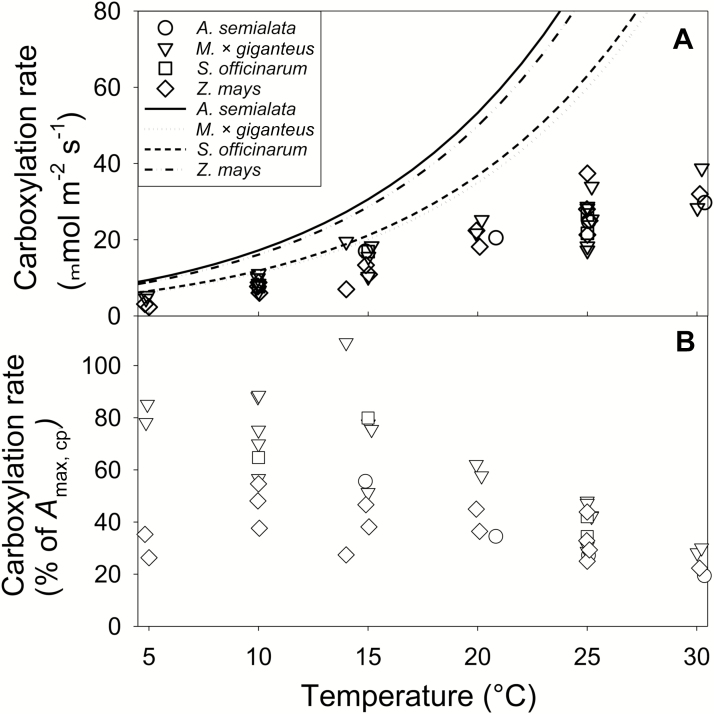
Comparison of theoretical maximum versus achieved leaf photosynthetic carboxylation rates at different temperatures. (A) Symbols indicate published rates of net CO2 uptake (Asat) measured on leaves at different temperatures. Lines show estimated leaf maximal photosynthetic capacity (Amax,cp) calculated from bundle sheath chloroplast volume per unit leaf area. (B) Measurements of Asat expressed as a percentage of Amax,cp. Measurements were obtained for Zea mays L. (Long, 1983; Naidu et al., 2003; Naidu and Long, 2004; Głowacka et al., 2016), Saccharum officinarum L. (Spitz, 2015; Głowacka et al., 2016), Alloteropsis semialata J. Presl (Osborne et al., 2008), and Miscanthus × giganteus Greef et Deu. (Naidu et al., 2003; Naidu and Long, 2004; Głowacka et al., 2014, 2015, 2016; Spitz, 2015; Friesen and Sage, 2016) at different temperatures and at an incident photon flux ≥1000 μmol m−2 s−1.